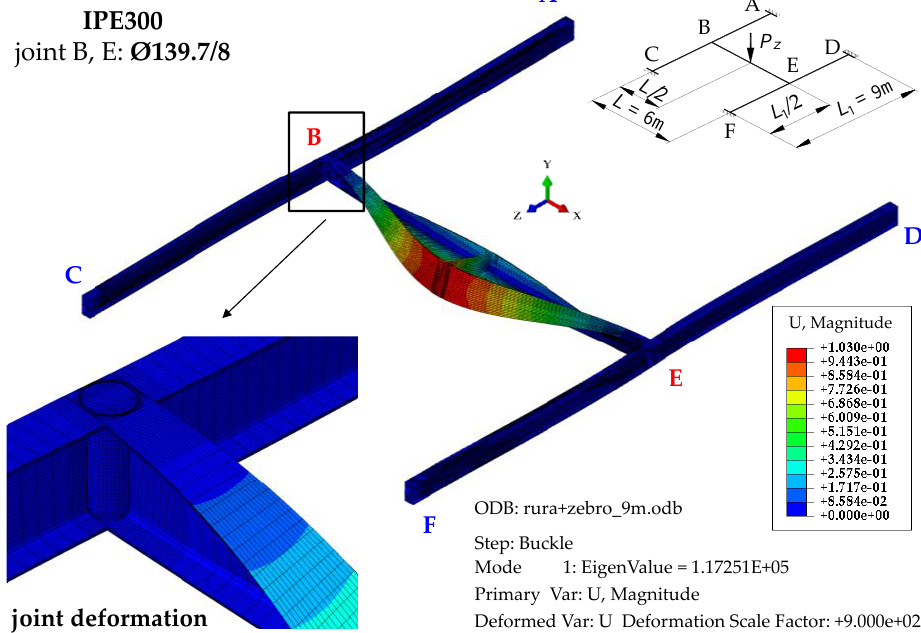
Figure 7. The mode of stability loss in exemplary H-grillage (IPE300, L = 6 m, L 1 = 9 m) with closed-section stiffeners at joints B and E, modelled in Abaqus.